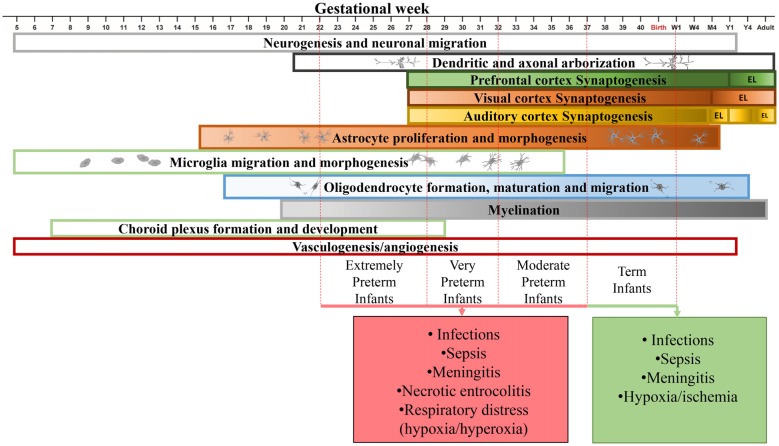
Time line of human brain development in the perinatal period. Developmental time course of neurons (Lenroot and Giedd, 2006; Budday et al., 2015; Paredes et al., 2016), synapses (Huttenlocher and Dabholkar, 1997; Glantz et al., 2007), astrocytes (Roessmann and Gambetti, 1986; Budday et al., 2015), microglia (Esiri et al., 1991; Monier et al., 2007), oligodendrocytes (Rakic and Zecevic, 2003; Yeung et al., 2014), myelination (Tosic et al., 2002; Yeung et al., 2014), choroid plexus (Dziegielewska et al., 2001) and vasculature (Budday et al., 2015) in the human brain. Major complications during the perinatal period are shown. W1, week 1; M4, month 4; Y1, year 1; EL, elimination.